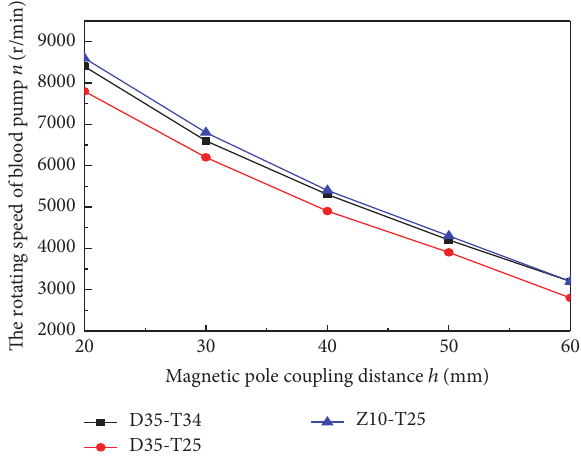
Figure 12: The variation law of rotational speed of blood pump with the coupling